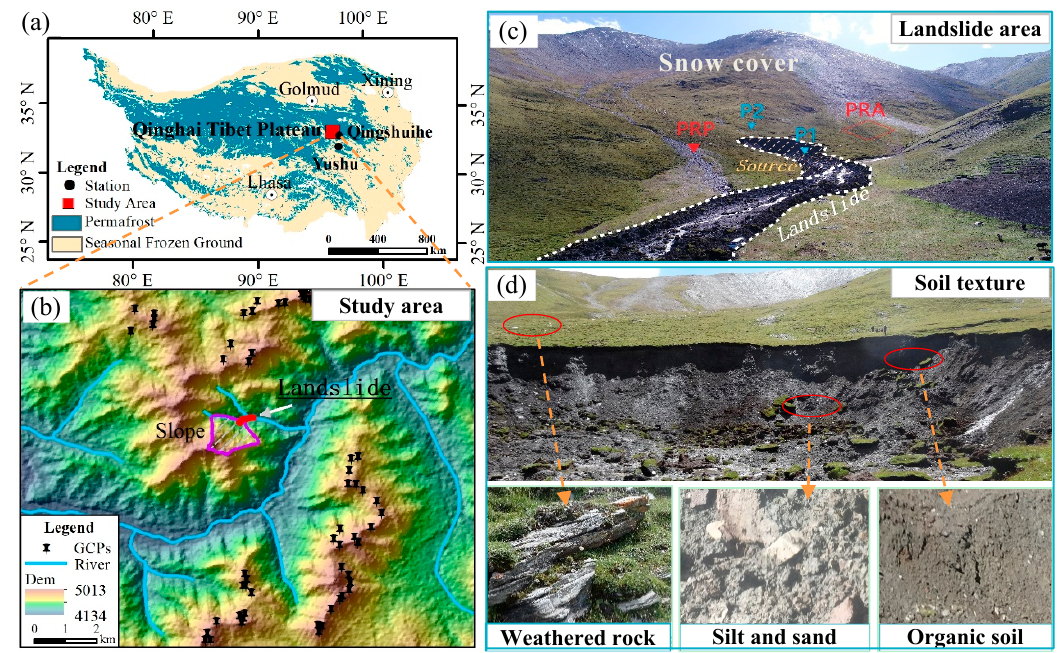
Figure 1. Location, topography( b ) and soil texture ( d ) of the landslide site ( c ) in study area in the Qinghai-Tibet Plateau ( a ). The permafrost distribution modified from [40] GCPs are the ground control points prepared for InSAR processing. Coherent points (P1 and P2) detected by InSAR. Zero-reference point (PrP) and zero-reference area (PrA) around the landslide.